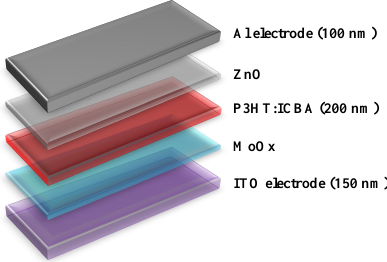
Figure 1. Solar cell device structure. The electron transport layer is ZnO, while the hole transport layer is MoOx. Both also act as optical spacer layers as they affect the distribution of light inside the device. We optimized these optical spacer layers for maximizing photon absorption inside the active layer of the solar cell.